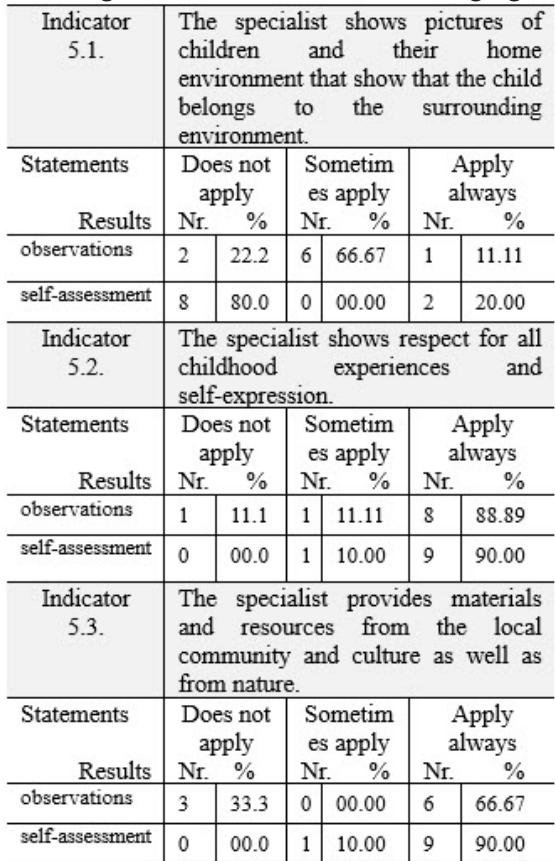
Table 30. Principle 5: The environment encourages each child’s sense of belonging.